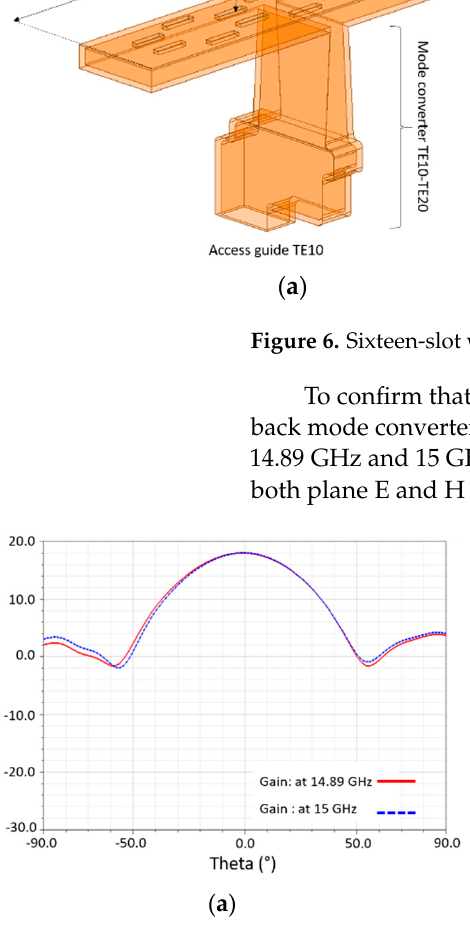
Figure 7. Simulated gain pattern at 14.89 and 15 GHz of the 16-slot waveguide antenna: ( a ) E-plane and ( b ) H-plane.